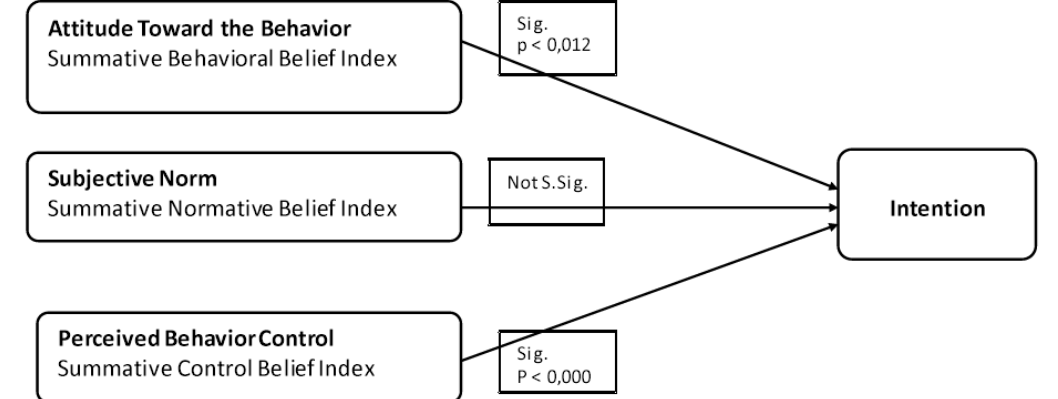
Figure 1 . Expected correlation between subscales of ATIPDPE